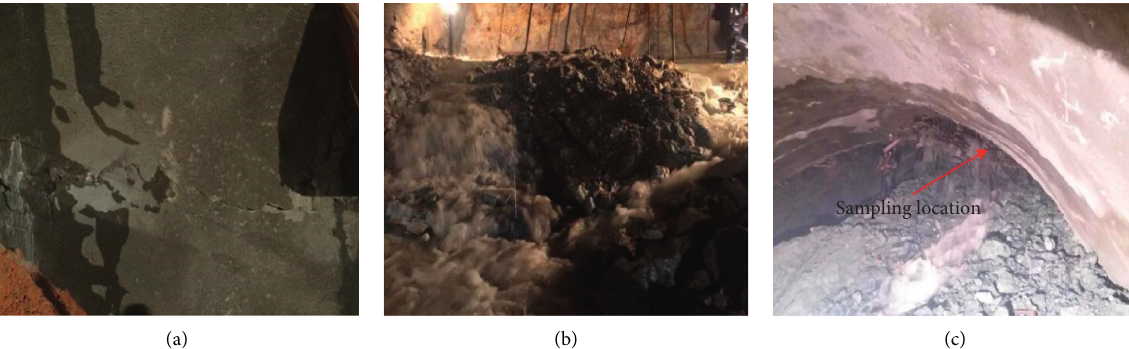
Figure 1: Images of initial supports cracking (a), water inrush phenomenon (b), and sampling points (c) of the Mila Mountain tunnel.